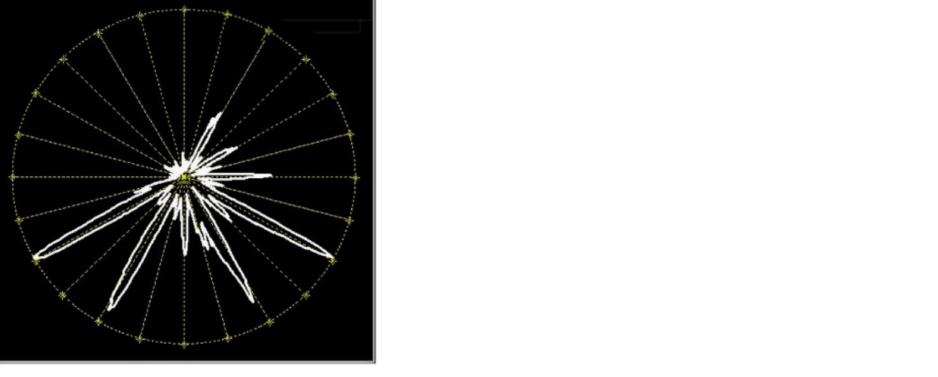
Figure 3. Front panel of the multidimensional data acquisition processor. The simplest description of cavitation comes out online after half an hour of measurement on the prototype. More compli- cated descriptions require days or weeks of recorded data analysis by a trained